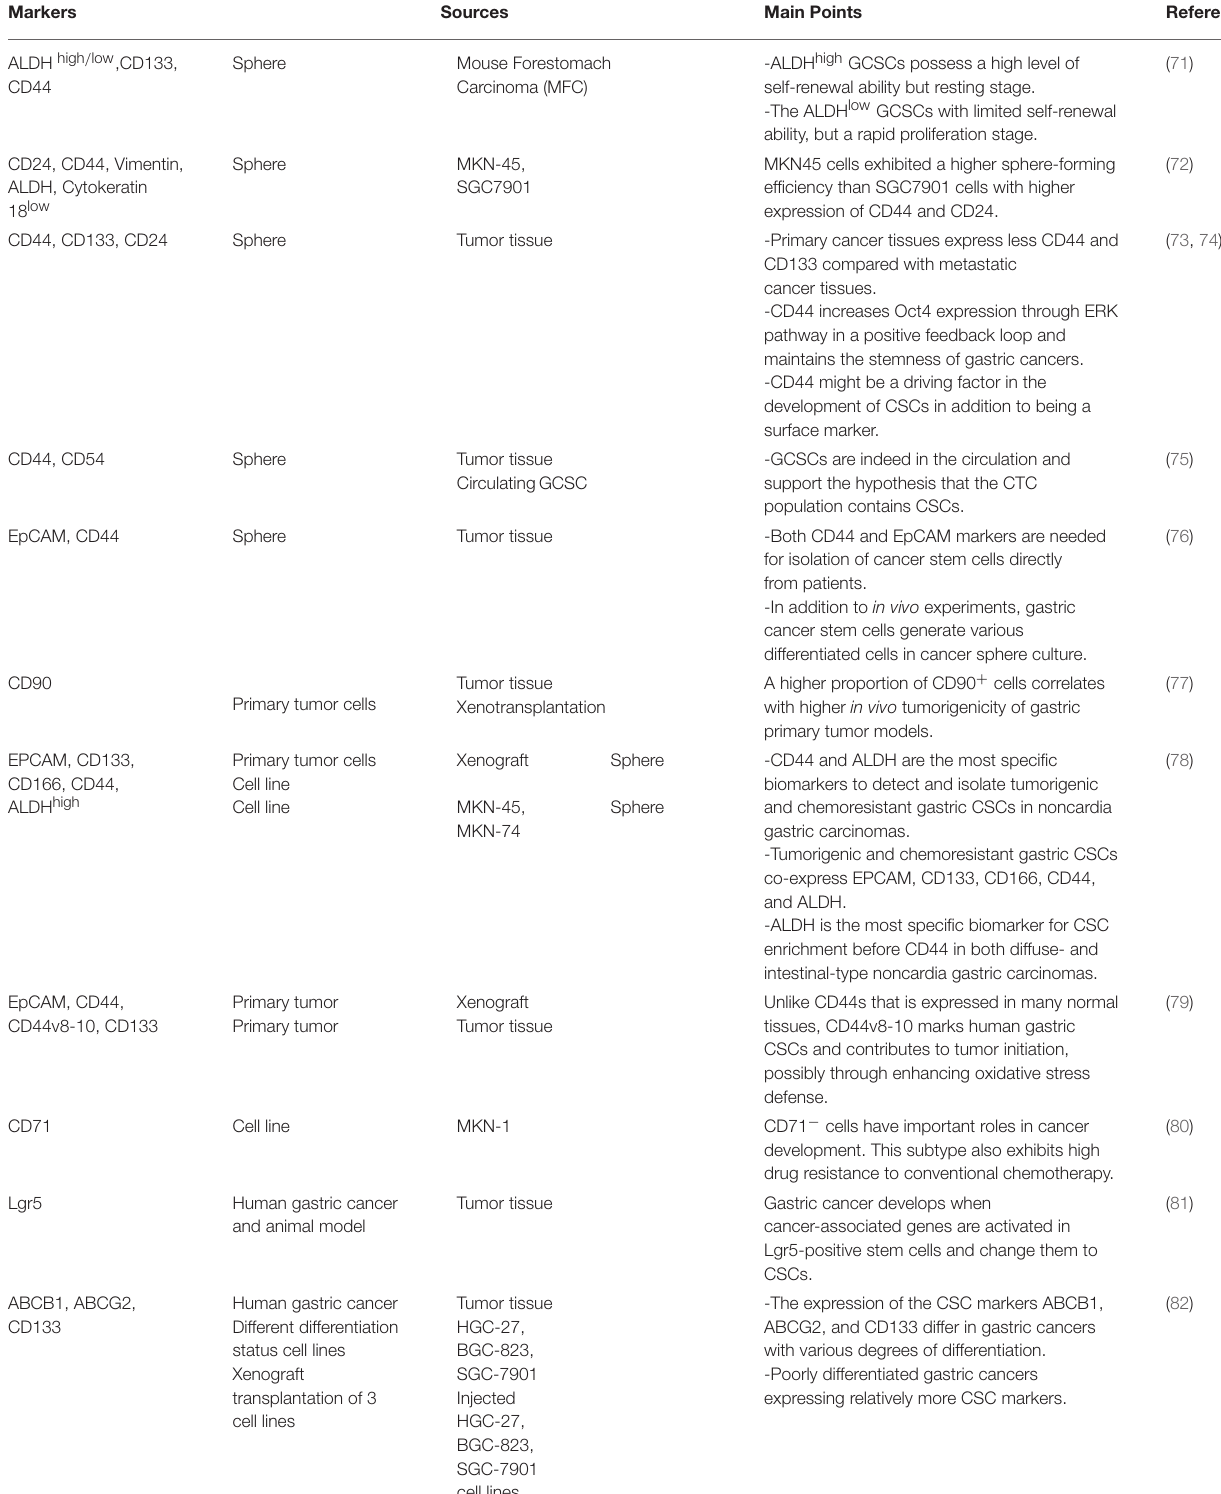
TABLE 2 | Gastric cancer stem cell markers.